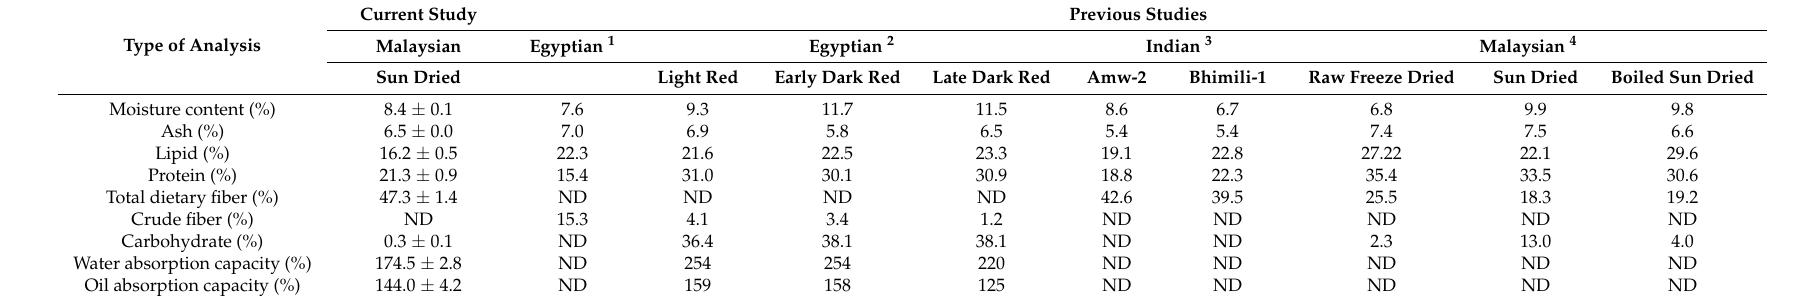
Table 1. Proximate composition, water and oil absorption capacity of different Roselle seed